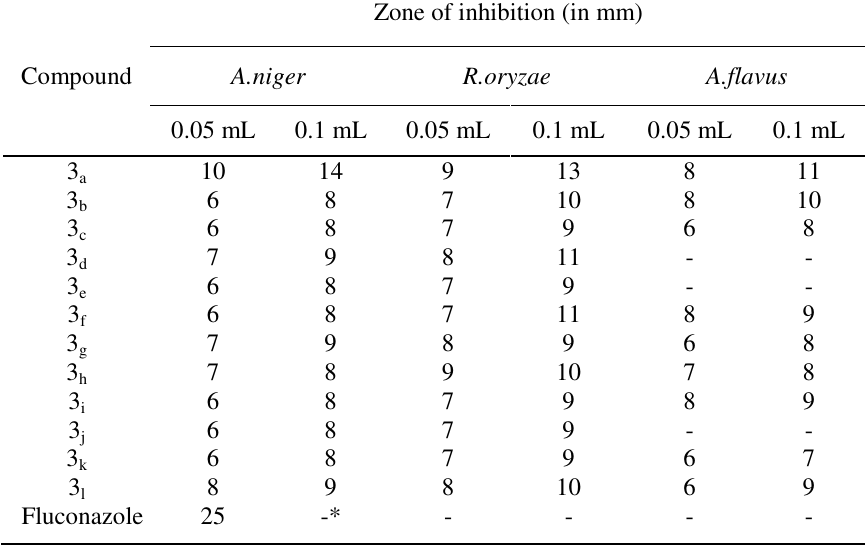
Table 2. Antifungal activity of chalcone derivates Zone of inhibition (in